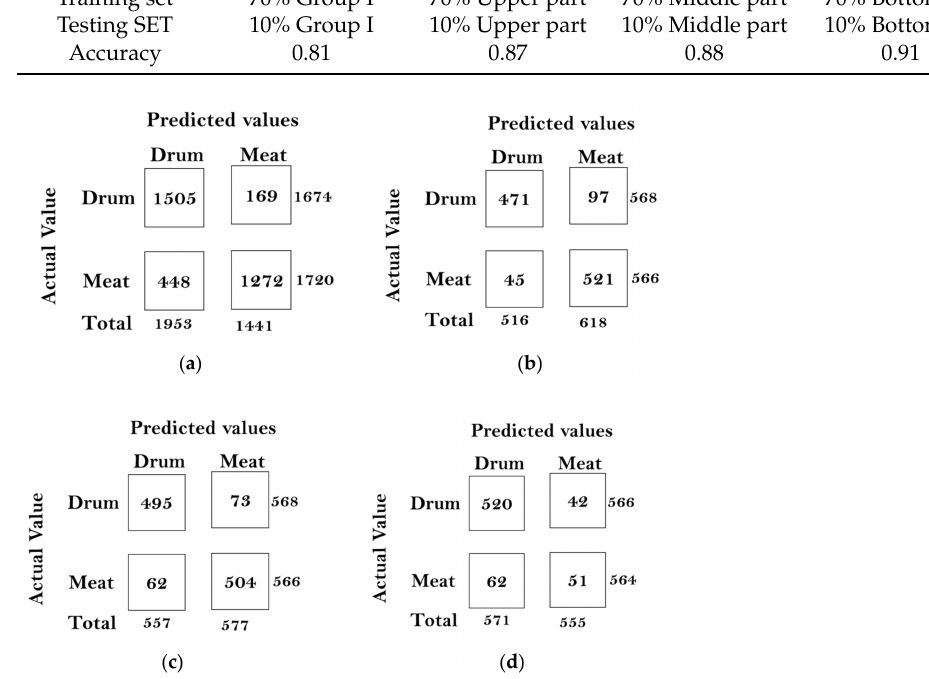
Figure 14. The confusion matrices ( a ) Group I, ( b ) Group I upper part, ( c ) Group I middle part, and ( d ) bottom